Question: Briefly state, in one sentence, what is plotted here.
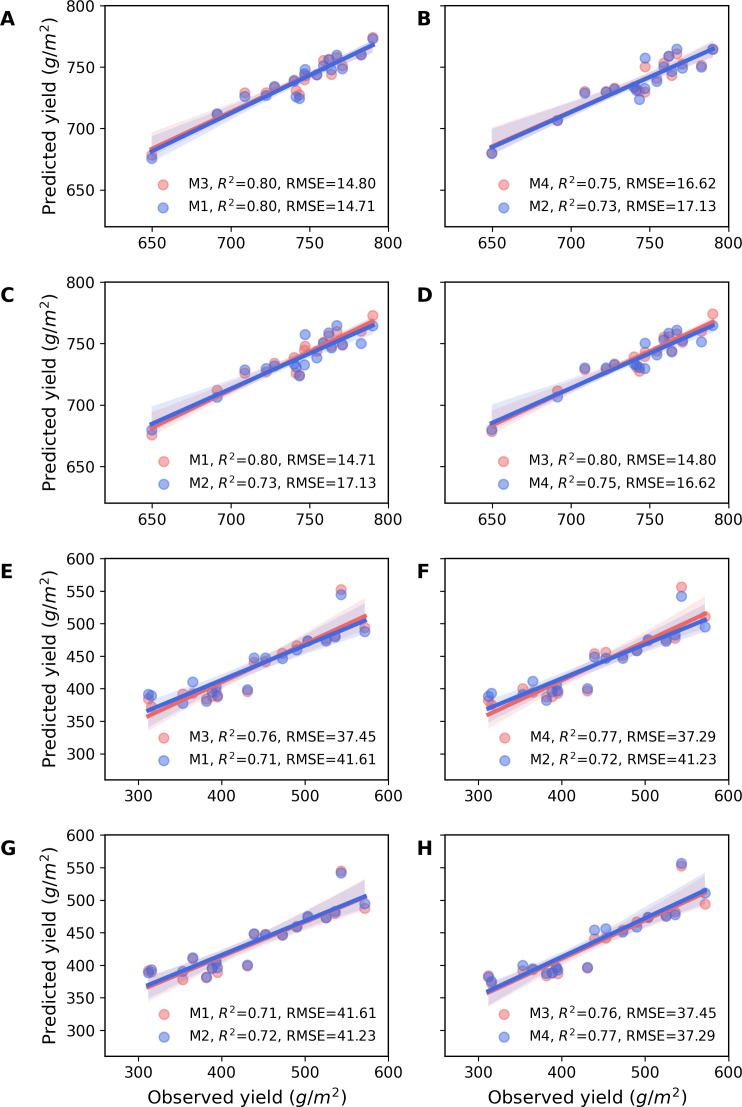
Answer: Correlation coefficient between the observed and predicted yield in 2022 (A-D) and 2023 (E-H) , respectively.